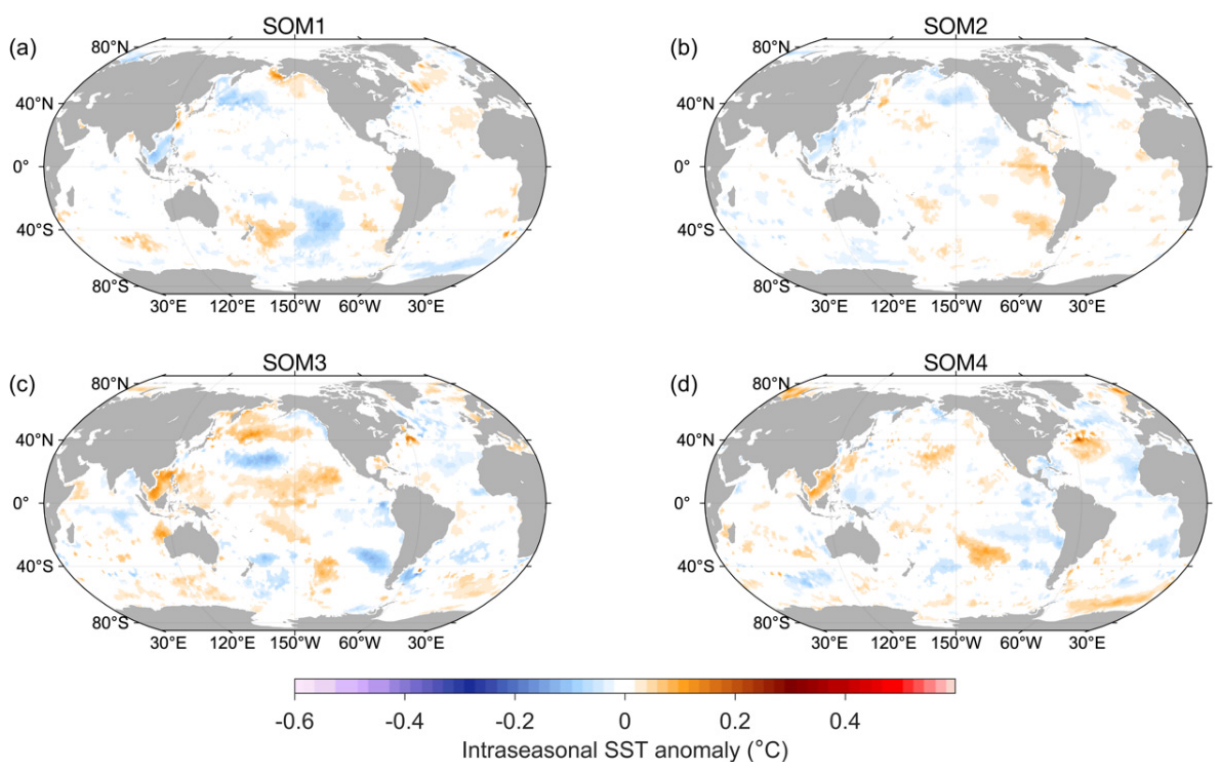
Figure 8. The same as Figure 6 except for the composites of the intraseasonal SST anomalies. The four plots are intraseasonal SST anomalies related to SOM1 ( a ), SOM2 ( b ), SOM3 ( c ), and SOM4 ( d ).